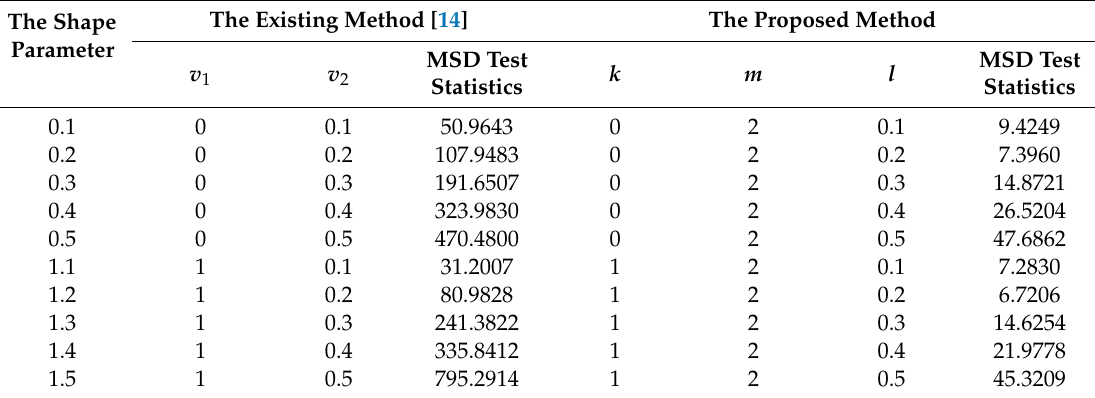
Table 2. MSD test statistics of Gamma distribution (Magnitude: 10 − 8